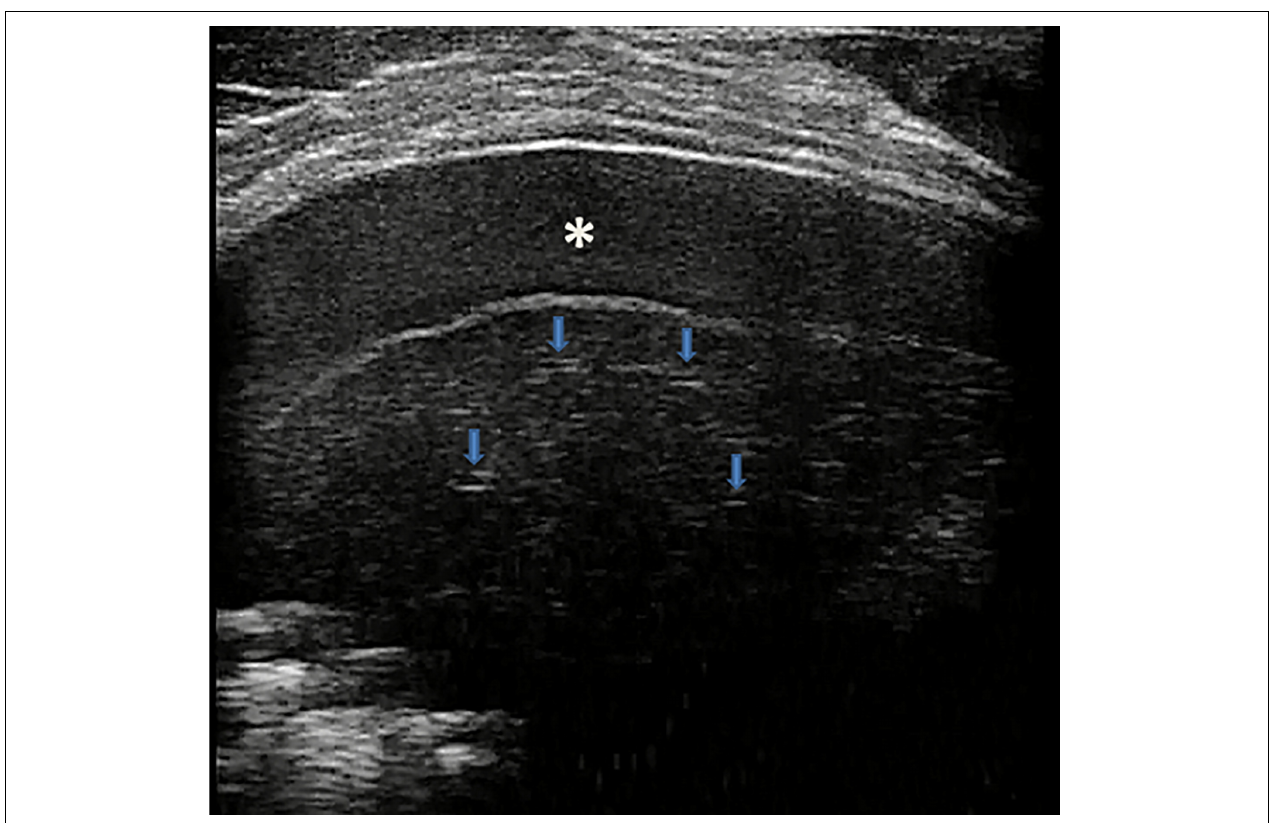
FIGURE 5 | Grayscale lung ultrasound examination (transverse scan between intercostal fields; linear probe with 12 MHz frequency) of a 7-year-old boy with bacterial lobar pneumonia, shows hepatized subpleural consolidation with fluid bronchograms ( arrows ) and fibrinous inflammatory reactive pleural effusion ( asterisk